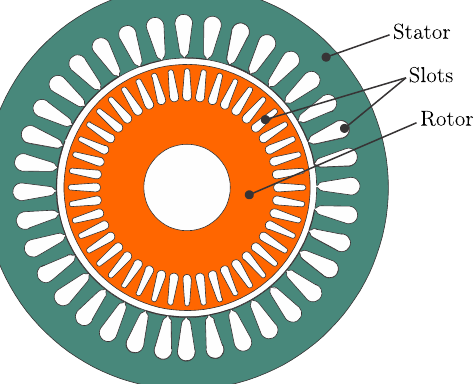
Figure 4. Preliminary design of the stator and rotor of an IM via ANSYS Maxwell